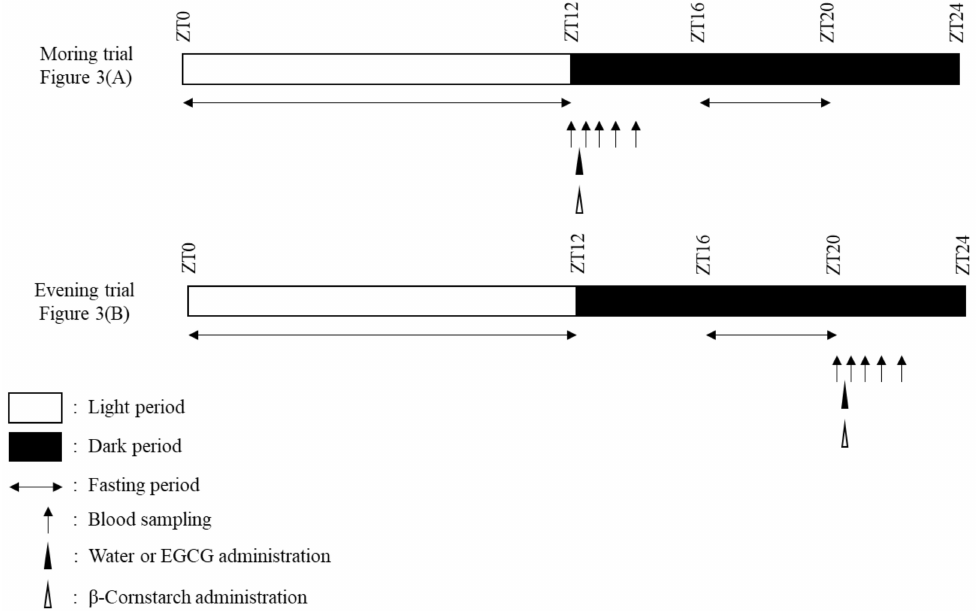
Figure 1. Protocol for acute experiments in